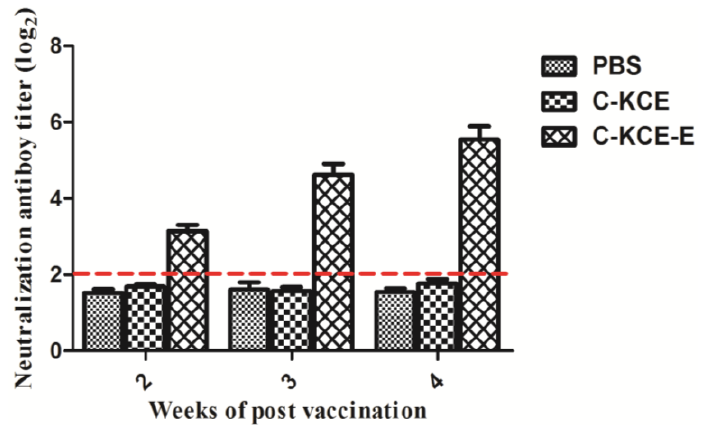
Figure 7. Antibody responses against duck Tembusu virus (DTMUV) induced by C-KCE-E immunization in ducks. Groups of five ducks were inoculated subcutaneously with 10 5 PFU of C-KCE-E, C-KCE or PBS as a negative control. Sera were collected in a range from two to four weeks to detect the NT antibody against DMTUV in nine-day-old specific-pathogen-free (SPF) chicken embryonated eggs. NT antibody titers for ducks are expressed as a log . Dotted lines indicate the thresholds for a positive 2